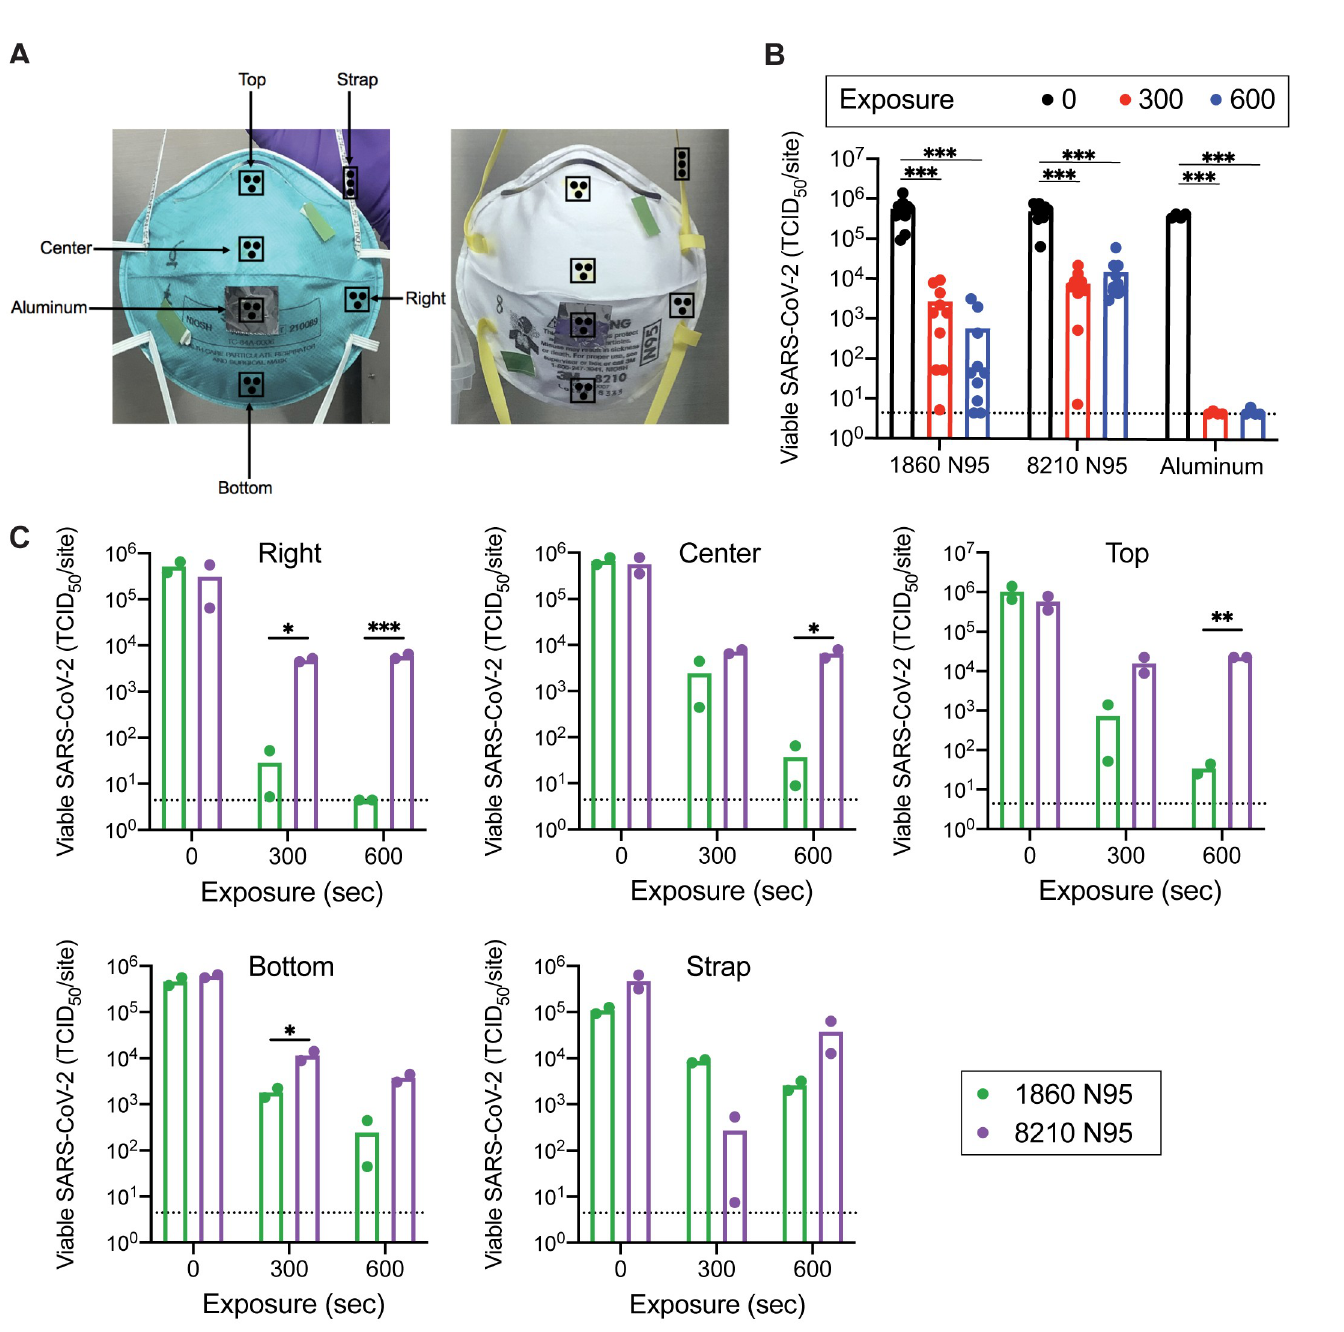
Fig 1. UV-C decontamination of multiple locations on two models of N95 respirators. (A) Schematic of mask inoculation sites. 3M 1860 and 3M 8210 masks were inoculated in five different locations plus an aluminum coupon adhered to the center of each mask. Each site was inoculated with 50 μ l of 8e 7 TCID 50 /ml virus, applied as three aliquots of 16.7 μ l. Inoculated masks were allowed to dry for 3.5 hours at room temperature in a biosafety cabinet before masks were exposed to UV-C irradiation. UV tape was adhered to masks to confirm irradiation. (B and C) Viable SARS-COV-2 recovered from inoculation sites. Viable virus at each inoculation site was quantified by end-point titration on Vero E6 cells and expressed as 50% tissue-culture infectious dose 50 (TCID 50 ) per site. Plots show the mean of two replicates from one experiment and are representative of two independent experiments. Dashed lines indicate the limit of detection (LOD), samples with no positive wells are plotted at LOD. (B) Data displayed by mask model; mean of data is displayed as a bar graph with individual sites shown as dots. (C) Data displayed by location of inoculation. � p < 0.05, �� p < 0.01, ��� p < 0.001.